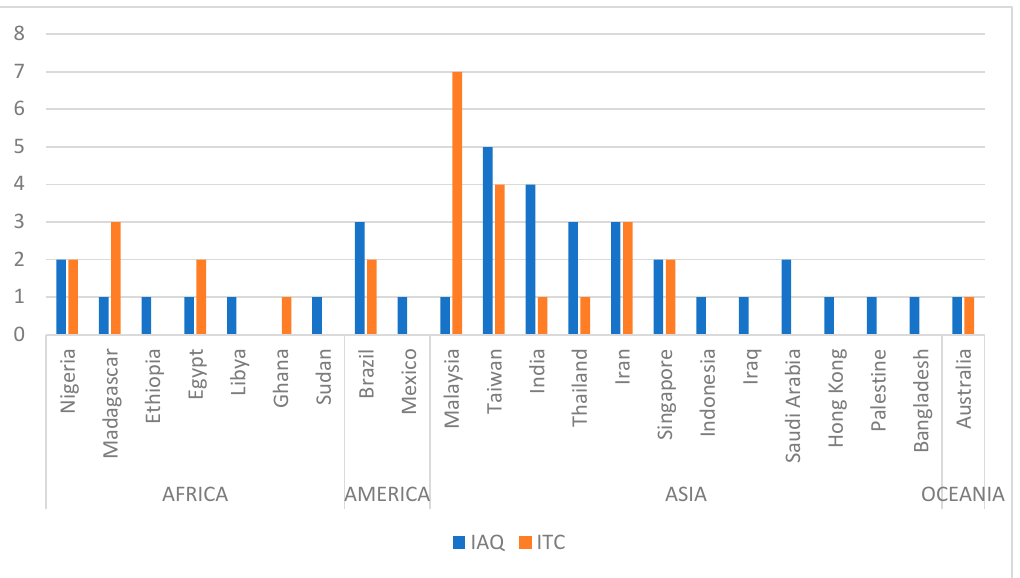
Figure 2. Distribution of the countries by the amount of the available and accessible studies on the IC parameters of the hospital environments.